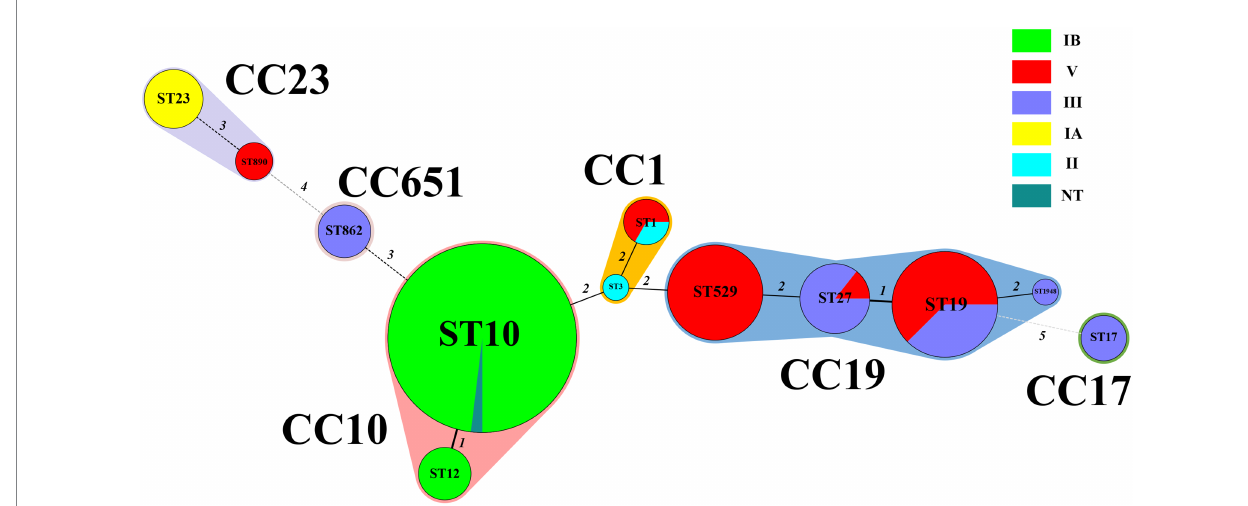
FIGURE 2 Minimum spanning tree of the 110 S. agalactiae strains showing the relationship between ST and cloning complexes (CC) by serotype. Circles represent sequence types (STs); size of each circle indicates the number of strains within the specific type. The serotypes of S. agalactiae strains appeared as different colours. Shading denotes STs belonging to the same CC. The numbers between the STs circles indicate the allelic difference between the adjacent STs. CC, clonal complex; ST, sequence type.